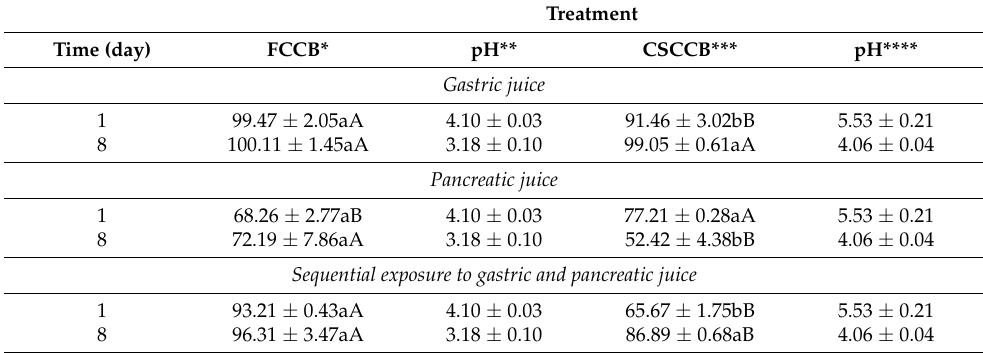
Table 1. Survival (%) of Lactobacillus paracasei subsp. paracasei LBC 81 during refrigerated storage at 4 ◦ C of FCCB and CSCCB, after simulated gastrointestinal